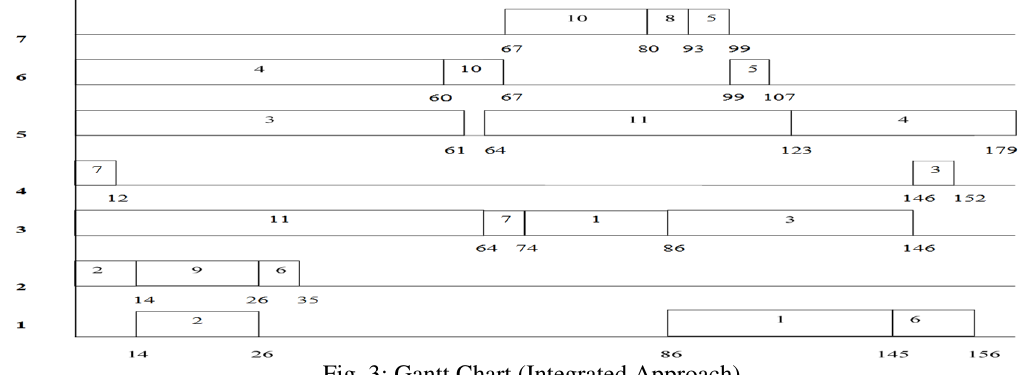
Fig. 3: Gantt Chart (Integrated Approach)